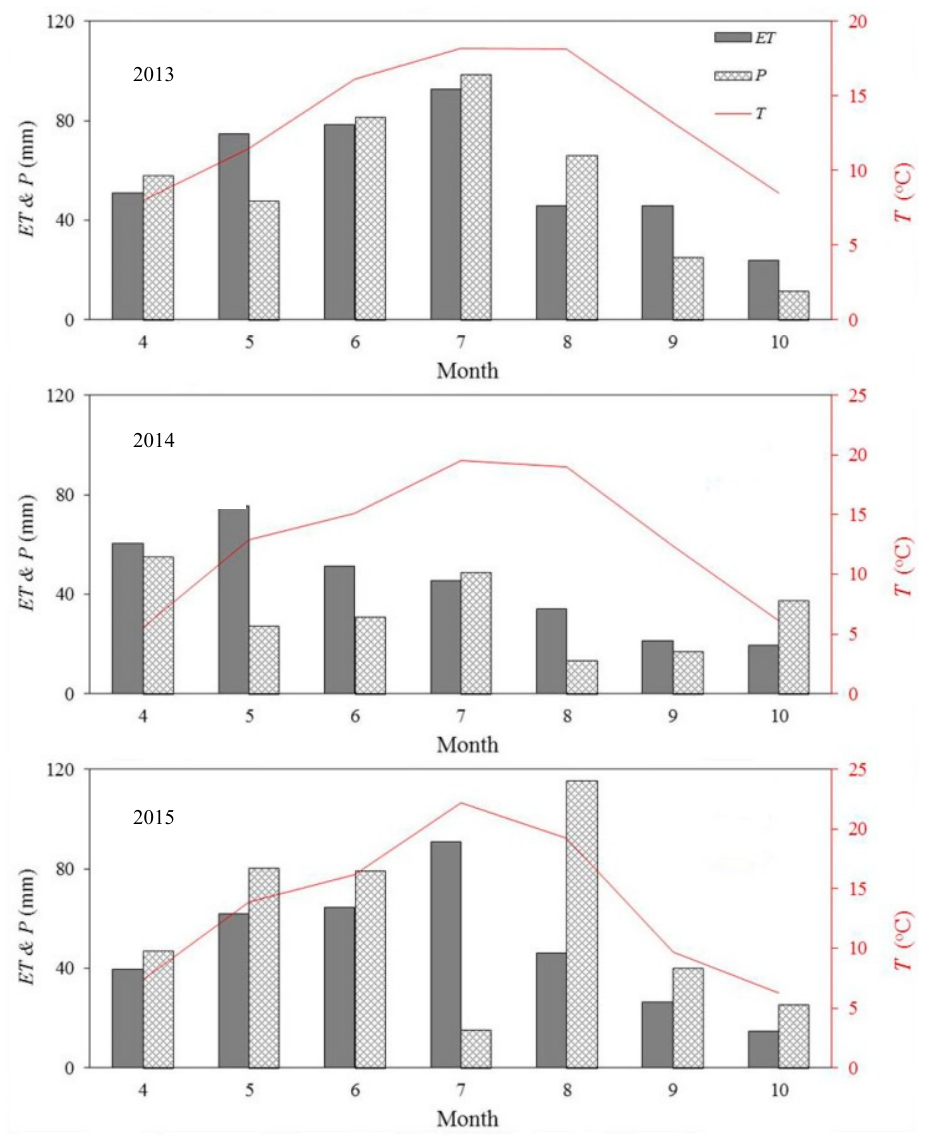
Figure 4. Comparison of the monthly evapotranspiration ( ET ), precipitation ( P ) and temperature ( T ) during the growing season from 2013 to 2015.